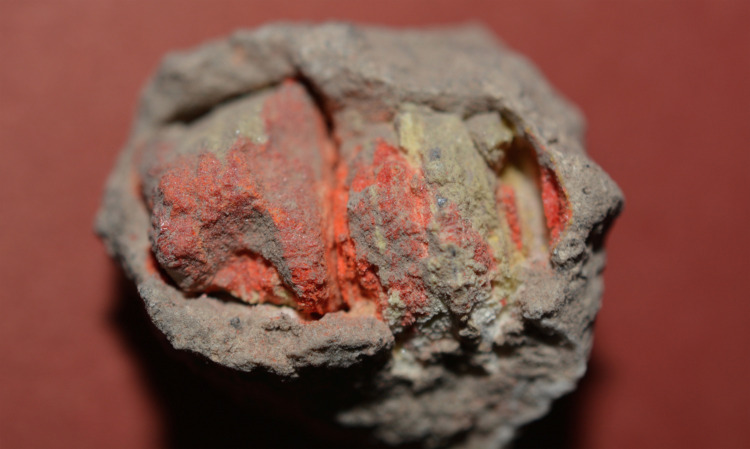
Orpiment–realgar ore fragment found in association with stibnite at the southern edge of Resuloğlu (square ZF 46), not to scale (© Resuloğlu excavations archive).